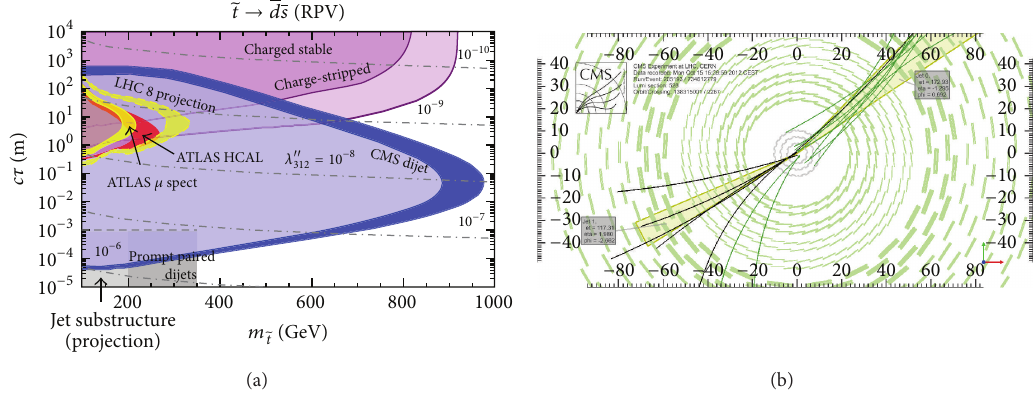
Figure 13: Results on limits on displaced jets searches [16] recast for baryonic RPV decays of squarks [19] (a). An event display [16] of the tracks that make a jet pair event from a displaced vertex (b). The yellow cones are the two jets making the pair and the black tracks are those fitting to a secondary vertex displaced by 5 cm. Same notation as in Figure